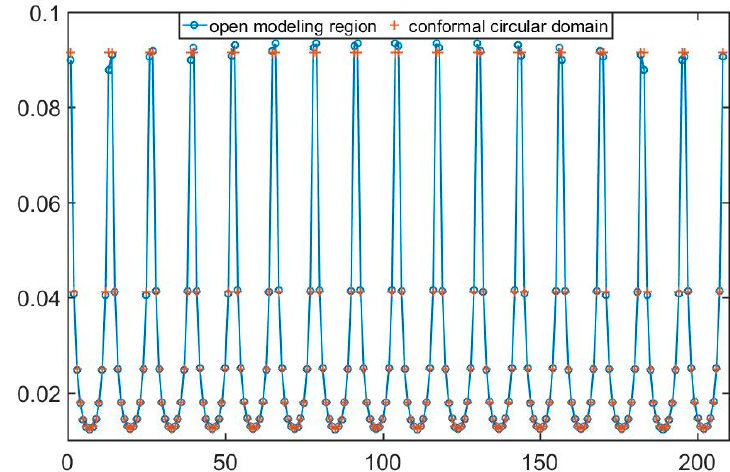
Figure 5. Boundary potential of reference field based on the open modeling region and its conformal circular domain.